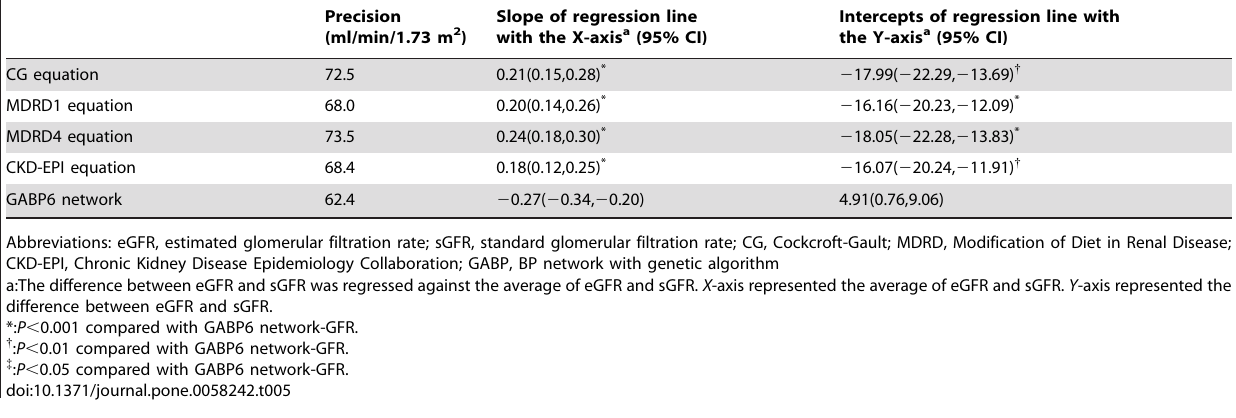
Slope of regression line Precision with the X-axis a (95% CI) (ml/min/1.73 m 2 )